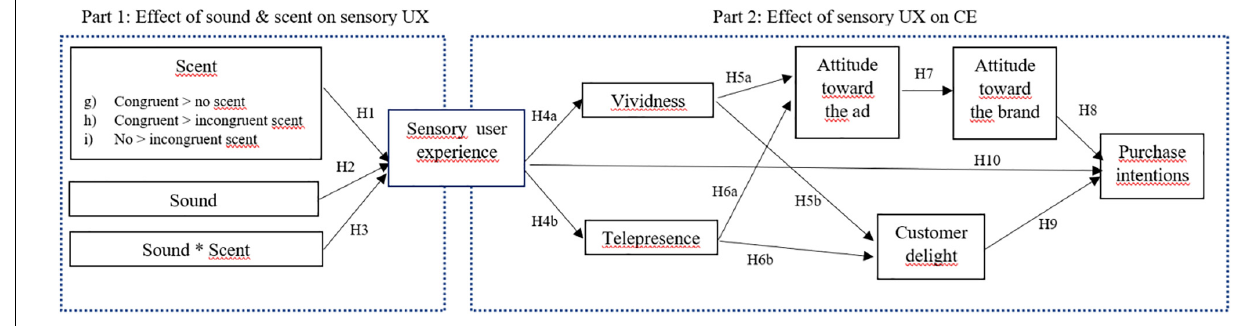
FIGURE 1 | Conceptual model